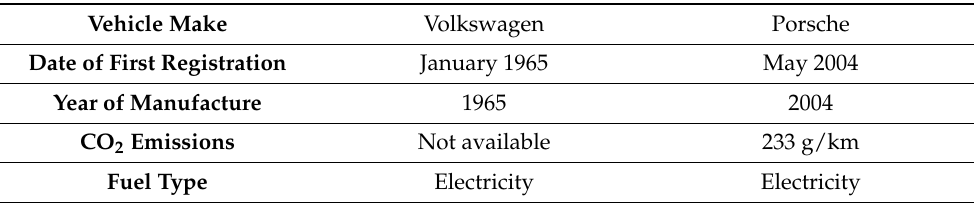
Table 6. Vehicle details of two retrofitted vehicles, highlighting the difference in information held by the DVLA. Information obtained from: